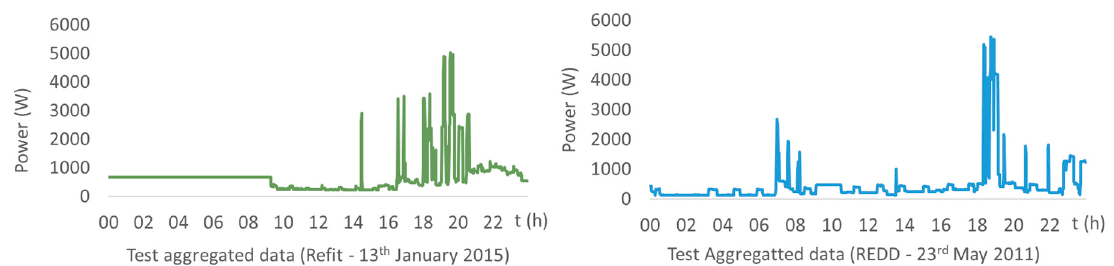
Figure 5. Aggregated load diagram for testing using Refit ( left ) and REDD ( right ) datasets.